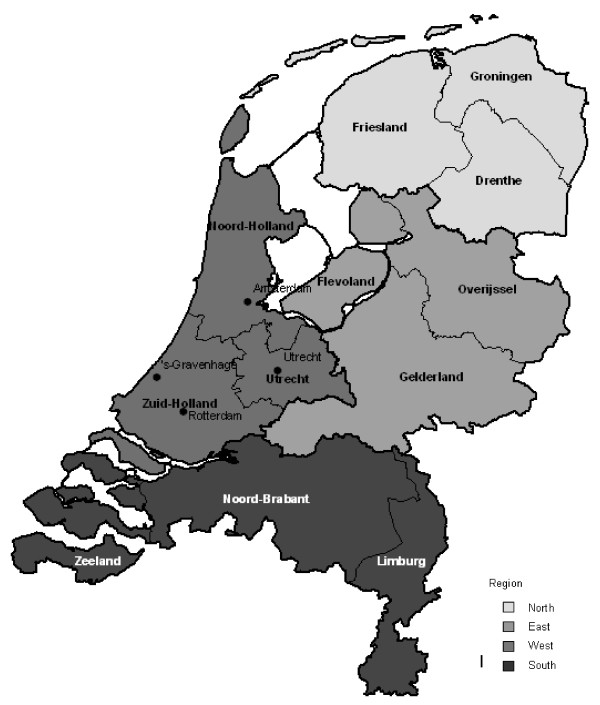
Provinces and regions in the Netherlands.